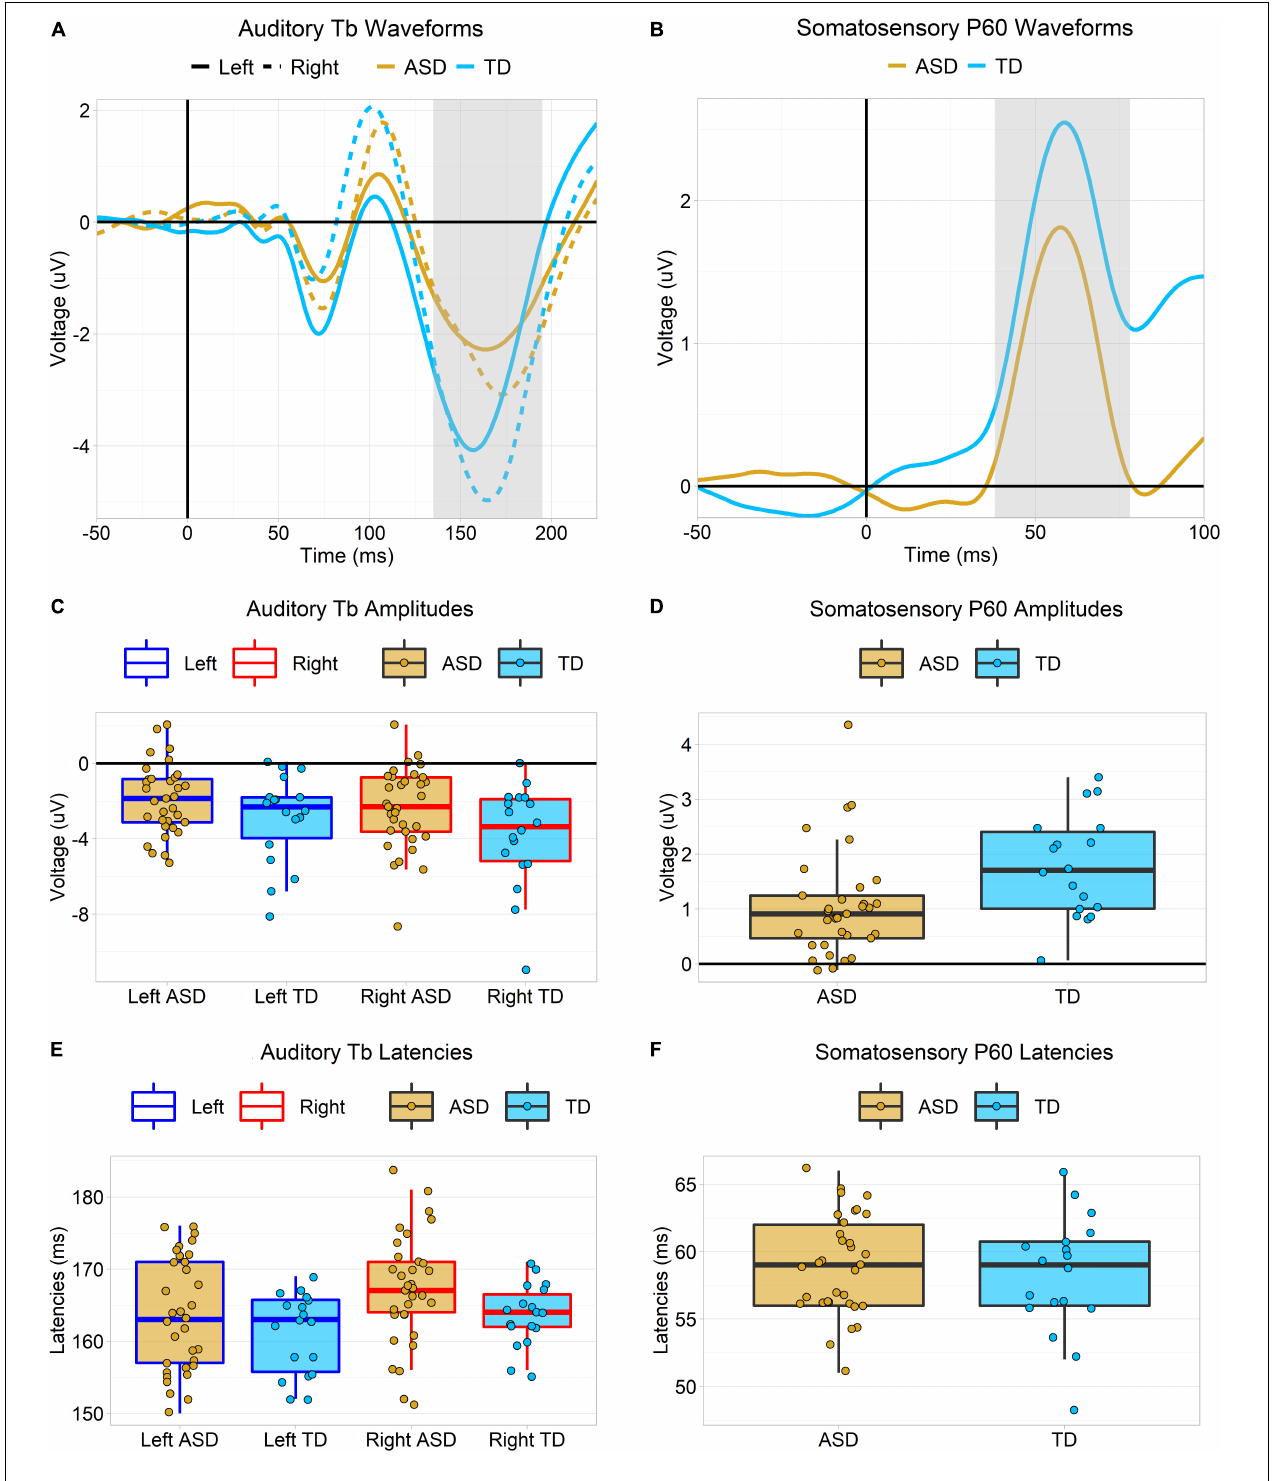
FIGURE 3 | Plots depicting Auditory Tb and somatosensory P60 ERP responses. (A,B) Tb and P60 ERP waveforms in each group. P60 responses are contralateral (left hemisphere only), but the Tb is shown over each hemisphere. The gray highlighted regions represent the measurement windows (Tb: 135–195 ms, P60: 38–78 ms). (C,D) Boxplots showing amplitudes of the Tb and P60 ERP responses. Amplitudes of both were greater in TD then ASD, but these effects dropped below the threshold for statistical significance after covarying for WISC PRI scores. Tb amplitudes were larger over the left hemisphere than the right. (E,F) Boxplots showing latencies of the Tb and P60 ERP responses. Latencies of the auditory Tb were faster in TD than ASD, but this effect was no longer significant after covarying for WISC PRI scores. Tb latencies were faster over the left hemisphere than the right.